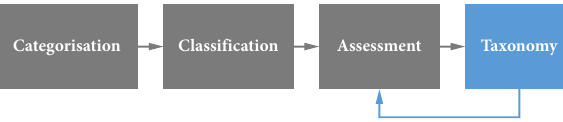
Figure 3. Stages of development for a taxonomy of